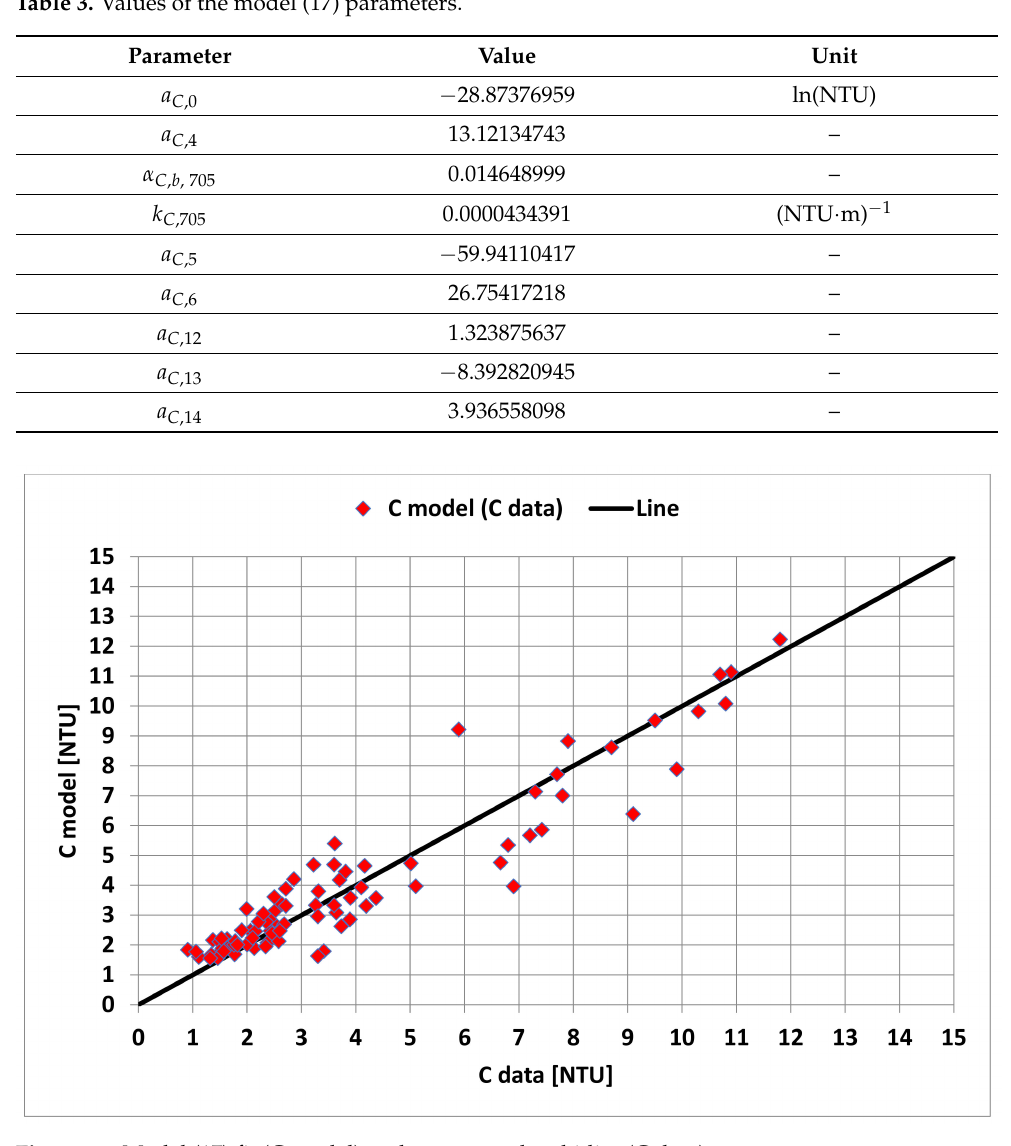
Figure 19. Model (17) fit (C model) to the measured turbidity (C